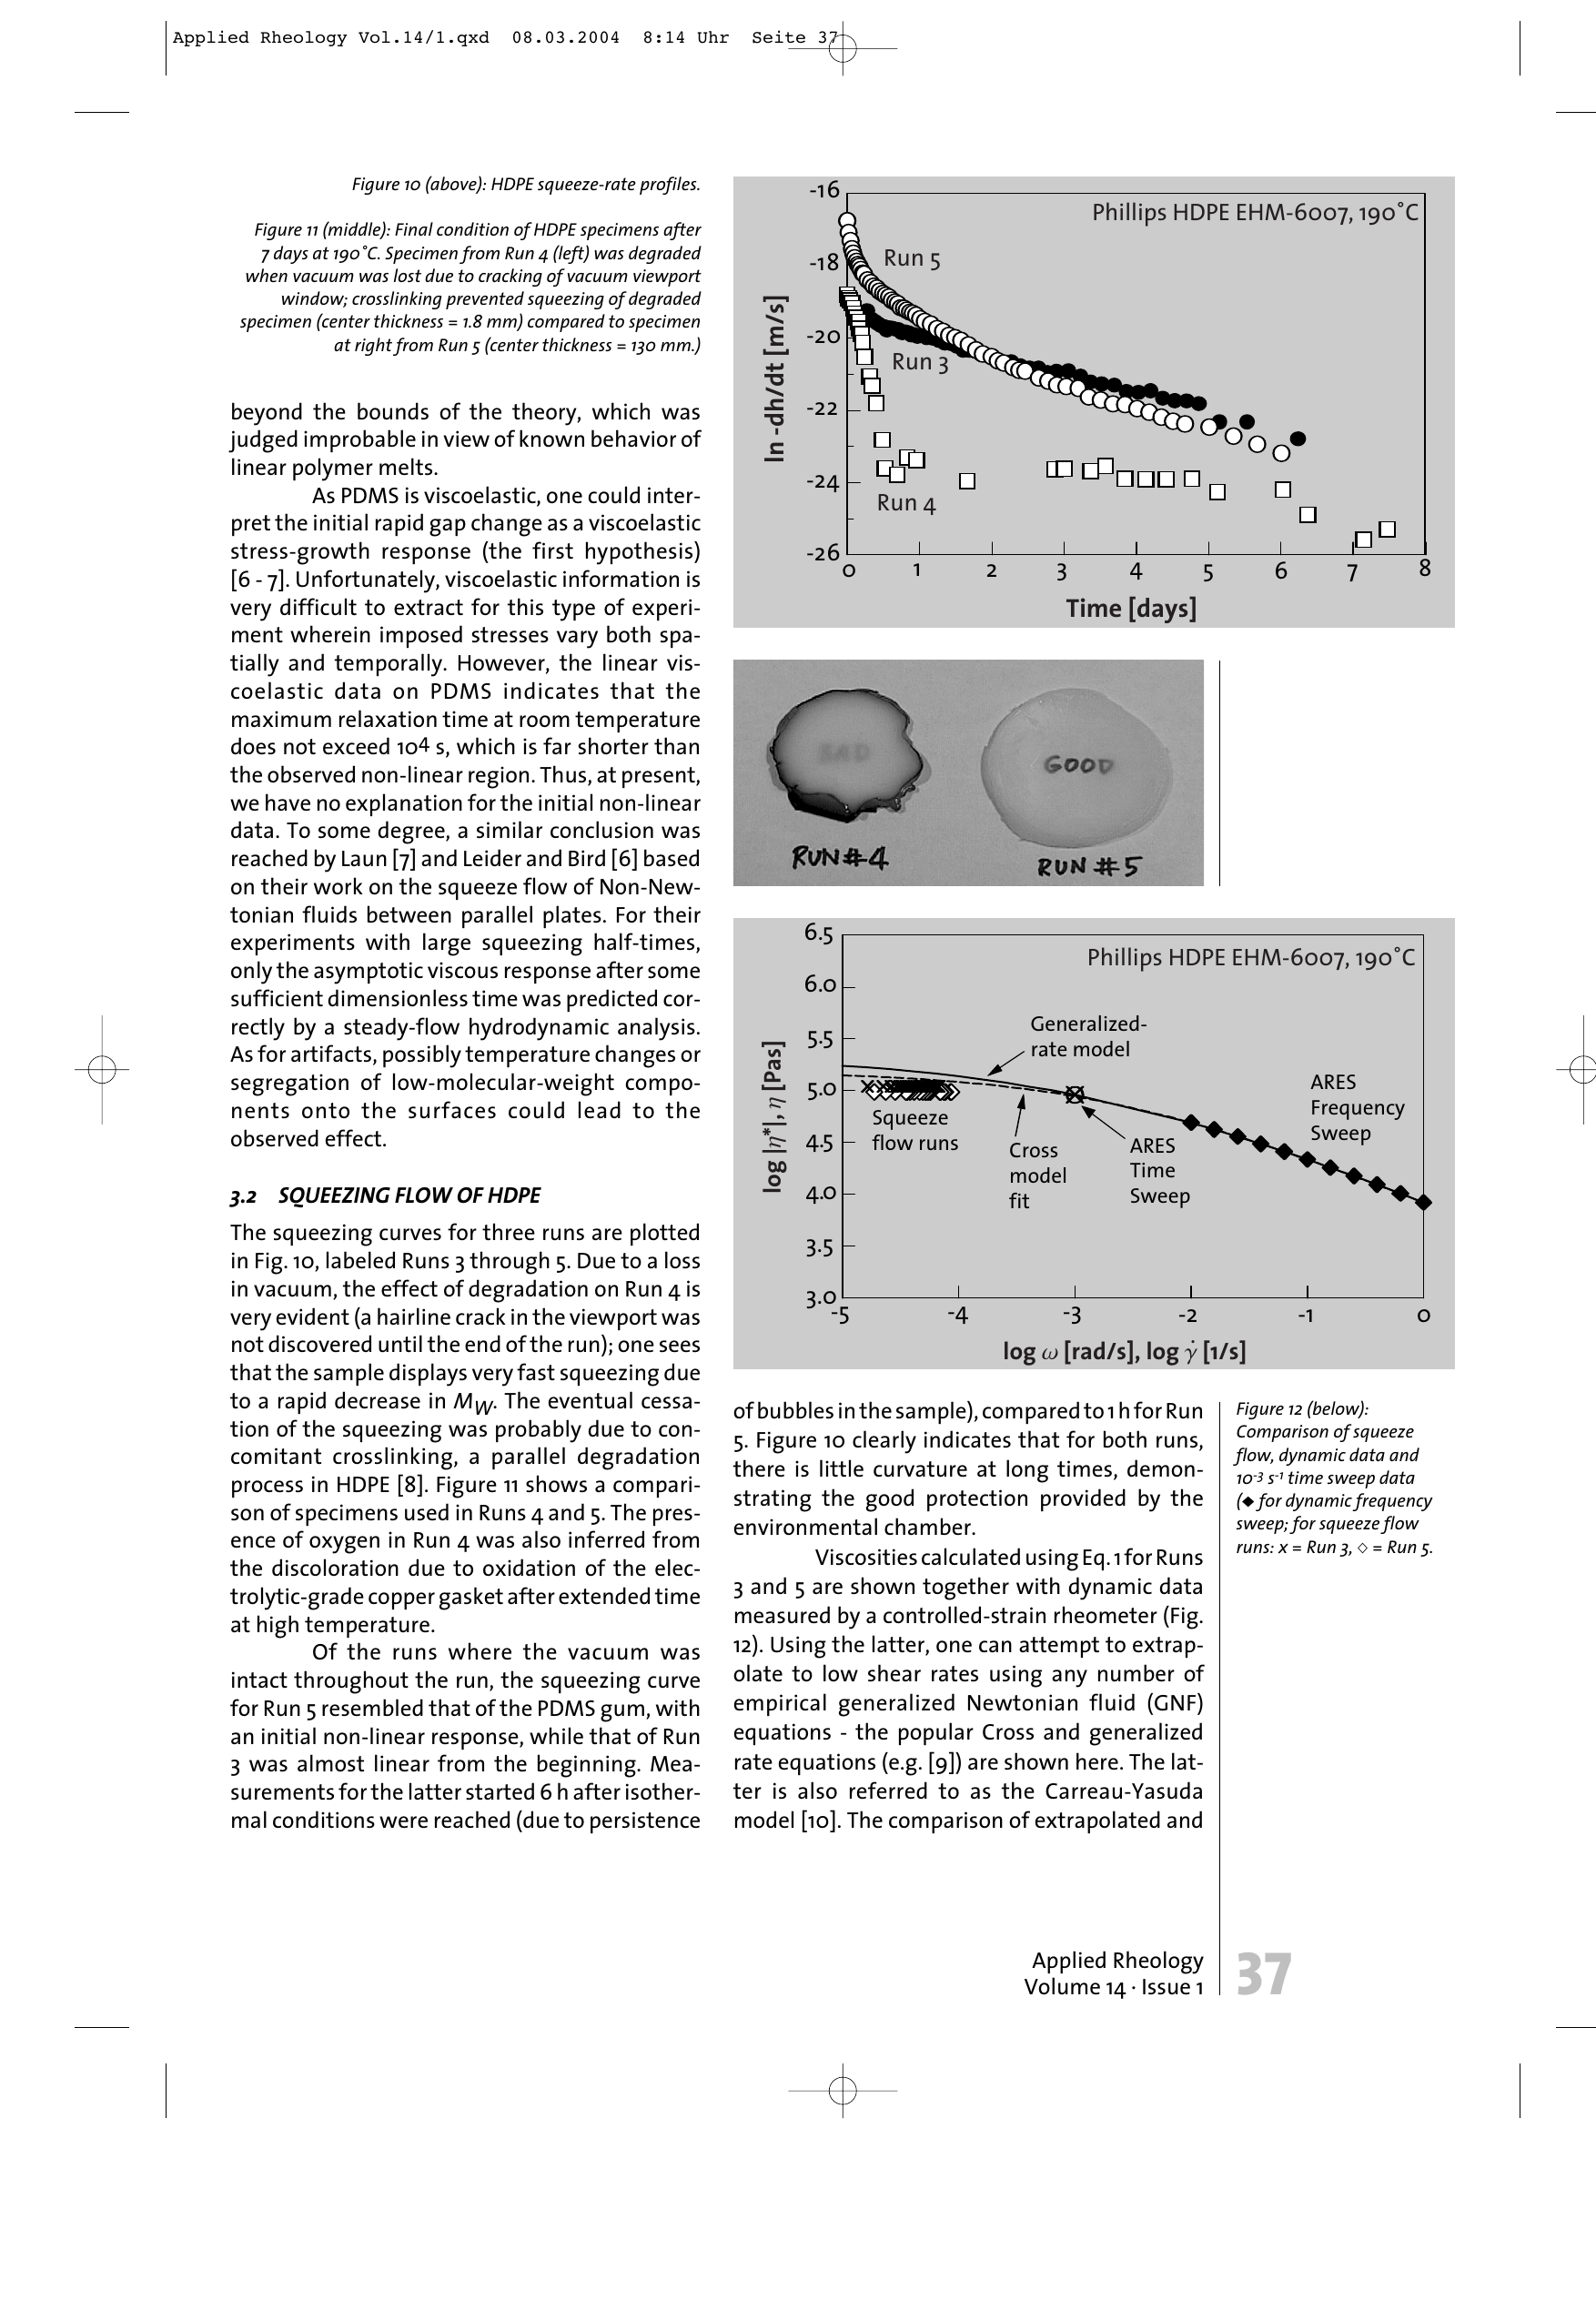
Figure 12 (below): Comparison of squeeze flow, dynamic data and 10 -3 s -1 time sweep data